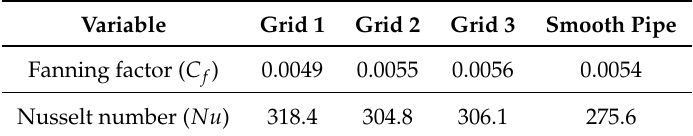
Table 5. Theoretical and numerical Fanning friction factor and Nusselt number obtained at Grids 1–3 using water.